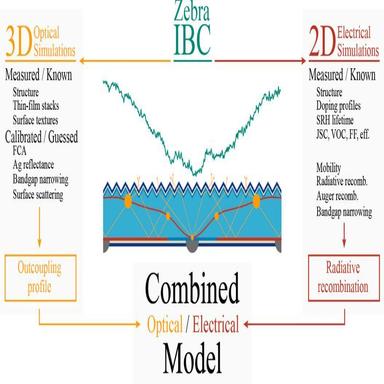
Schematic diagram of the proposed combined opto-electrical luminescence modelling approach.